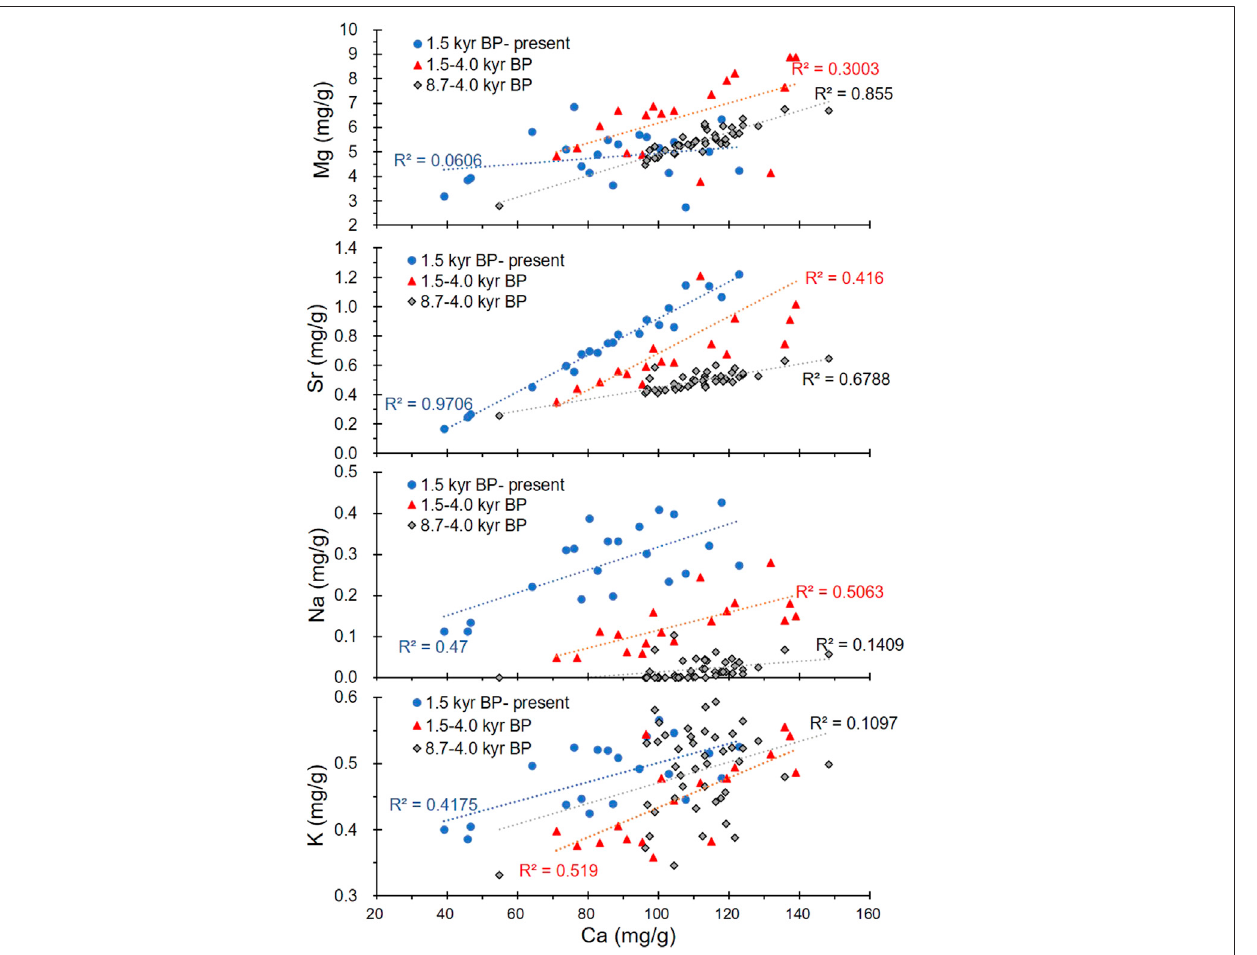
FIGURE 8 | Correlations between the Ca and Mg, Sr, Na, and K contents of the carbonates.